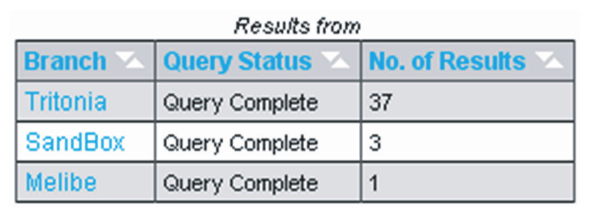
FIGURE 6 | Cross branch query results. The query from Figure 5 was submitted to all branches. The number of results obtained from each branch is displayed in the column on the right. Clicking on the name of the branch takes the user to the results for that branch.